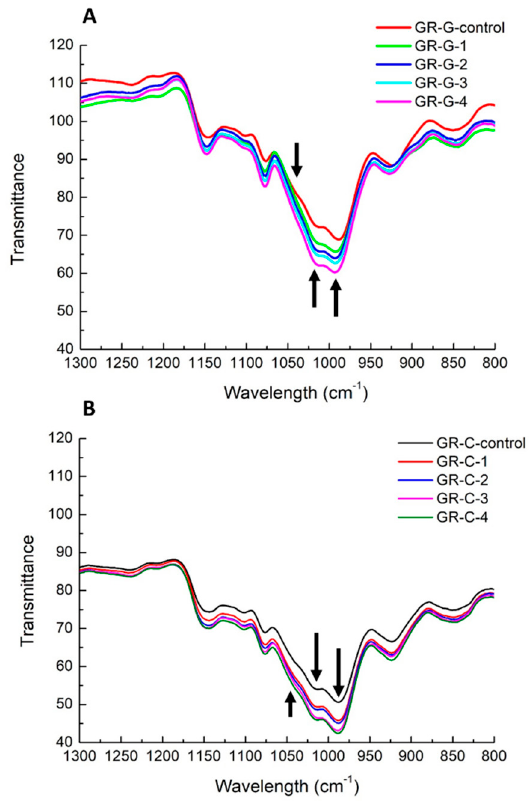
Figure 6. Overlay FTIR spectra of control glutinous rice gel ( A ) sample (GR-G-control) and control sweetened glutinous rice cake ( B ) sample (GR-C-control) and rice samples with 100 (GR-G-1, GR-C-1), 200 (GR-G-2, GR-C-2), 300 (GR-G-3, GR-C-3) and 400 (GR-G-4, GR-C-4) pulses of PEF treatment at 3 kV/cm after 14 days of storage at 4 ◦ C at the regions of 1300–800 cm − 1 . Arrows indicate the peaks at the wavelength of 995, 1022 and 1047 cm − 1